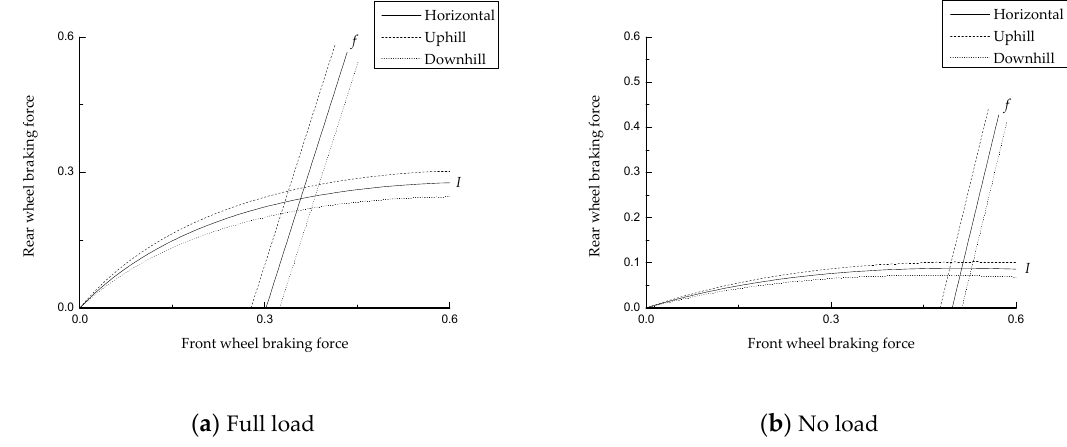
Figure 5. Vehicle front and rear axle braking force. ( a ) Full load; ( b ) no load.